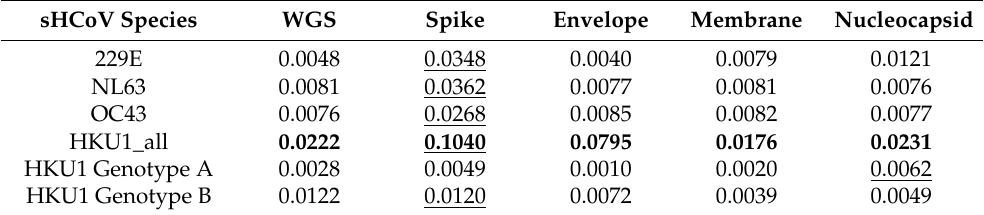
Table 3. Mean pairwise genetic distances for each sHCoV species derived from WGS and four ORFs from dataset D4. In bold is the highest pairwise distance for each ORF/WGS and underlined is the highest pairwise distance for each sHCoV species. sHCoV Species WGS Spike Envelope Membrane Nucleocapsid 229E 0.0048 0.0348 0.0040 0.0079 0.0121 NL63